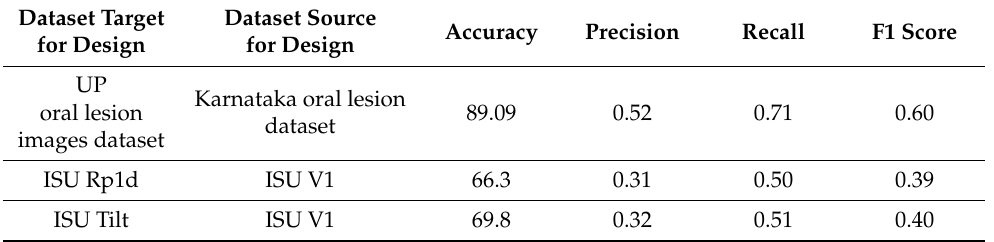
Table 11. Results for reusing pipeline designs created for one image processing dataset on